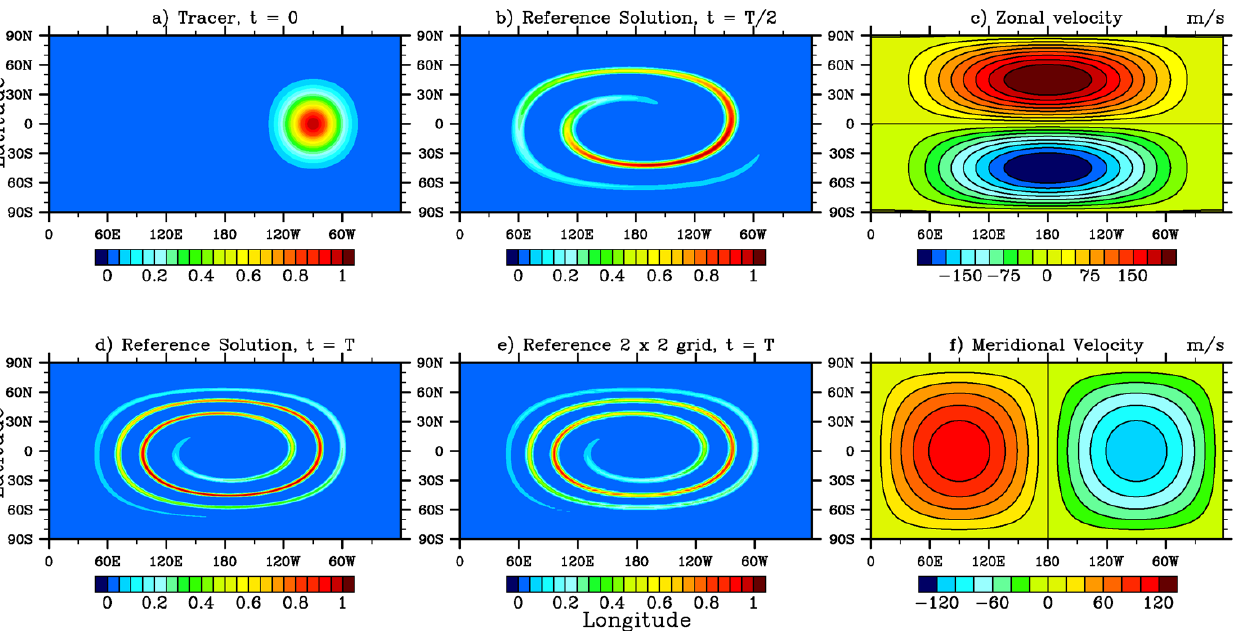
Fig. 2. As Fig. 1 but for test